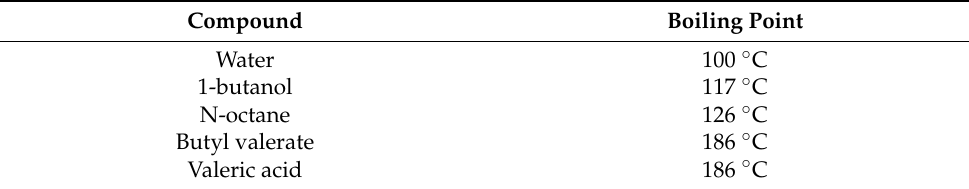
Table 3. Boiling points (at 1 bar) of the present compounds in the process